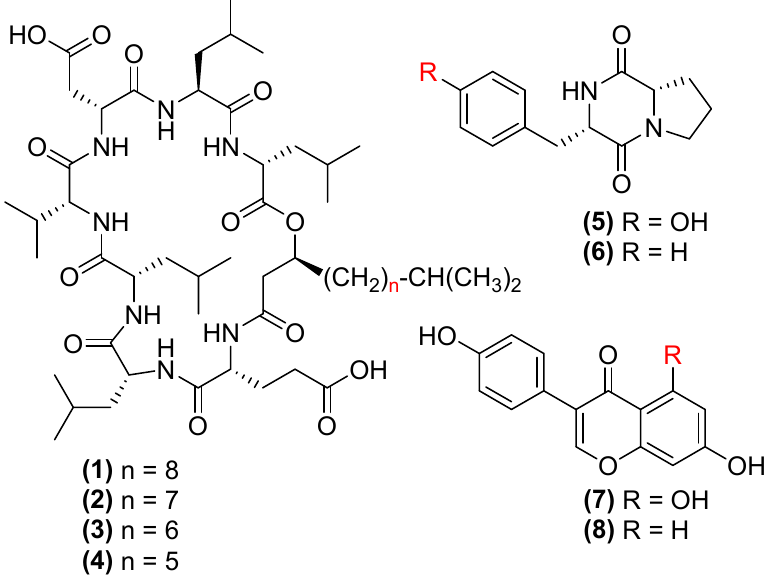
Figure 3. The chemical structures of C16 ‐ C13 surfactin C (1–4), maculosin (5), maculosine 2 (6), genistein (7) and daidzein (8).